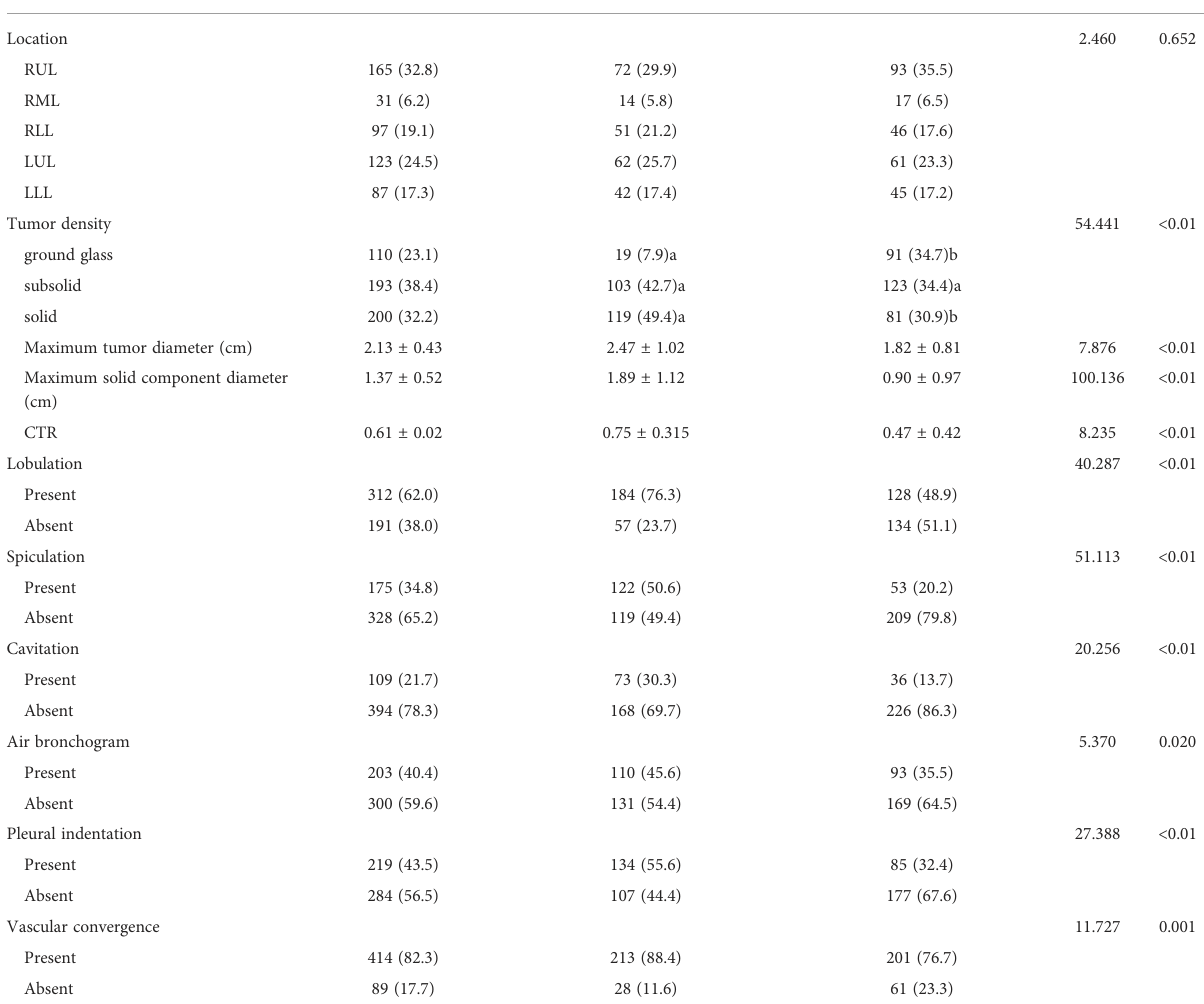
TABLE 3 Association between STAS and CT features (x ̅ ±s/n [%]).